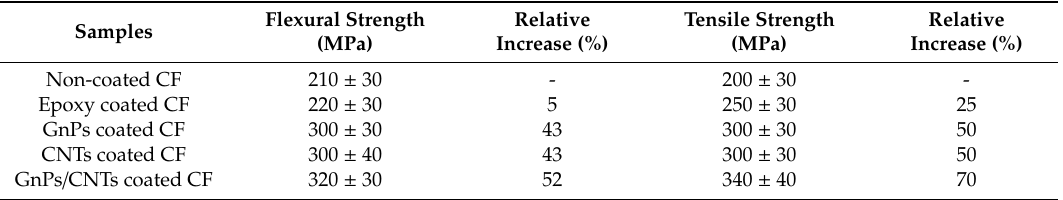
Table 2. The flexural strength and tensile strength of CF / EP composites.